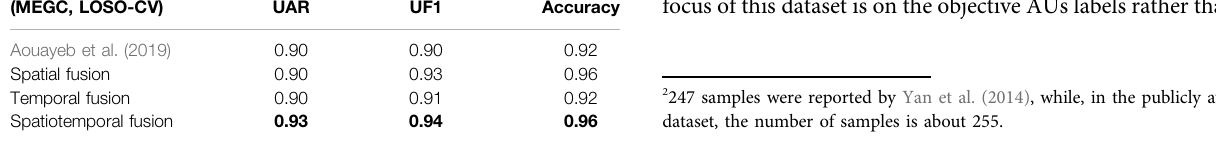
TABLE 5 | Performance of the spatial and temporal fusion blocks. (MEGC, LOSO-CV) UAR UF1 Accuracy Aouayeb et al. (2019)